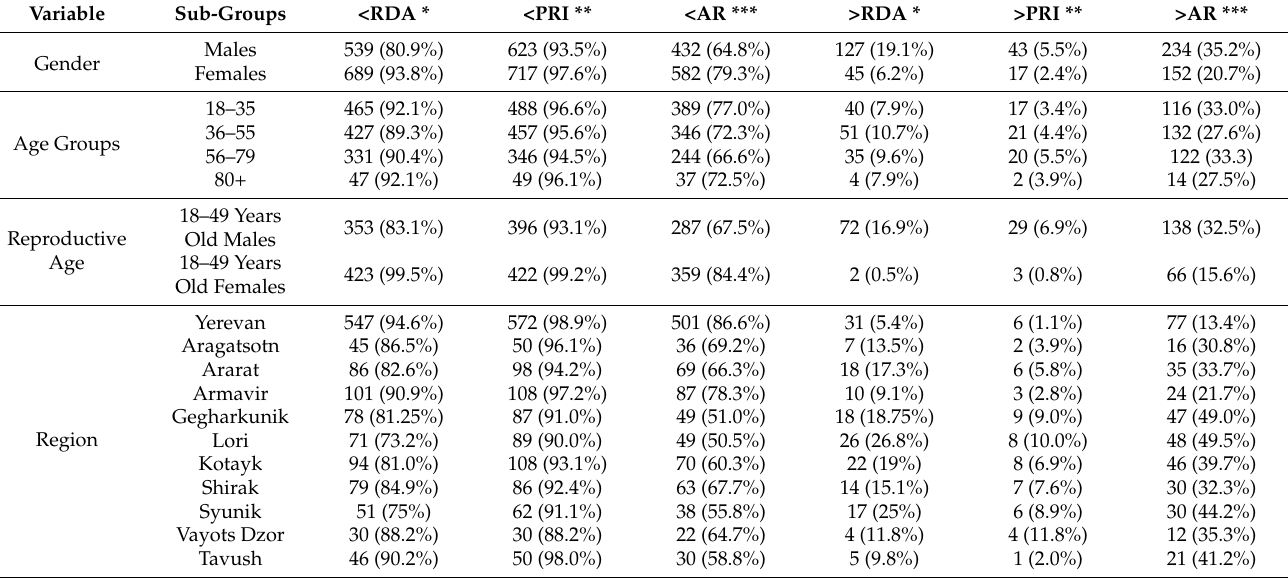
Table 5. Share of individuals characterized by adequate or inadequate iron